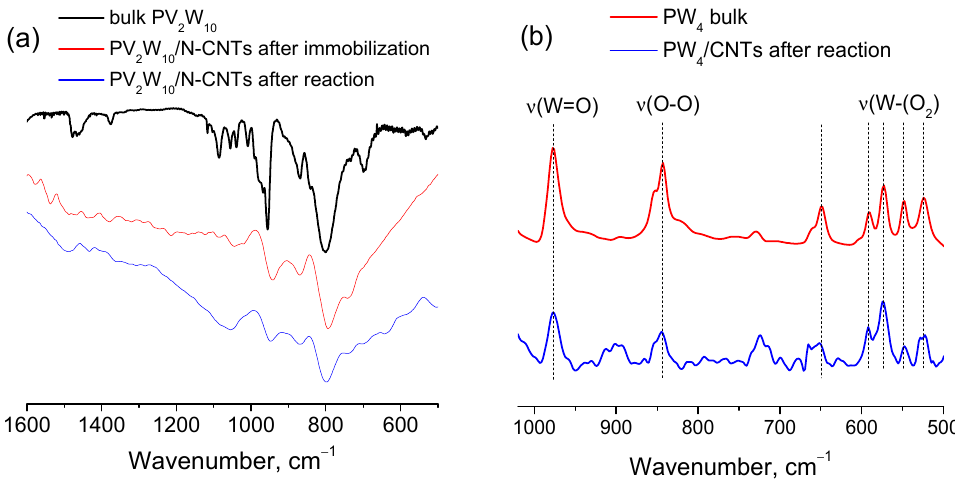
Figure 12. FT-IR spectra of ( a ) bulk PV 2 W 10 , 8 wt. % PV 2 W 10 /N-CNTs, and 8 wt. % PV 2 W 10 /N-CNTs after 2,3,6-trimethylphenol oxidation and ( b ) bulk PW 4 and 15 wt. % PW 4 /CNTs catalyst after cyclooctene oxidation (the spectra of (N)-CNTs were subtracted).